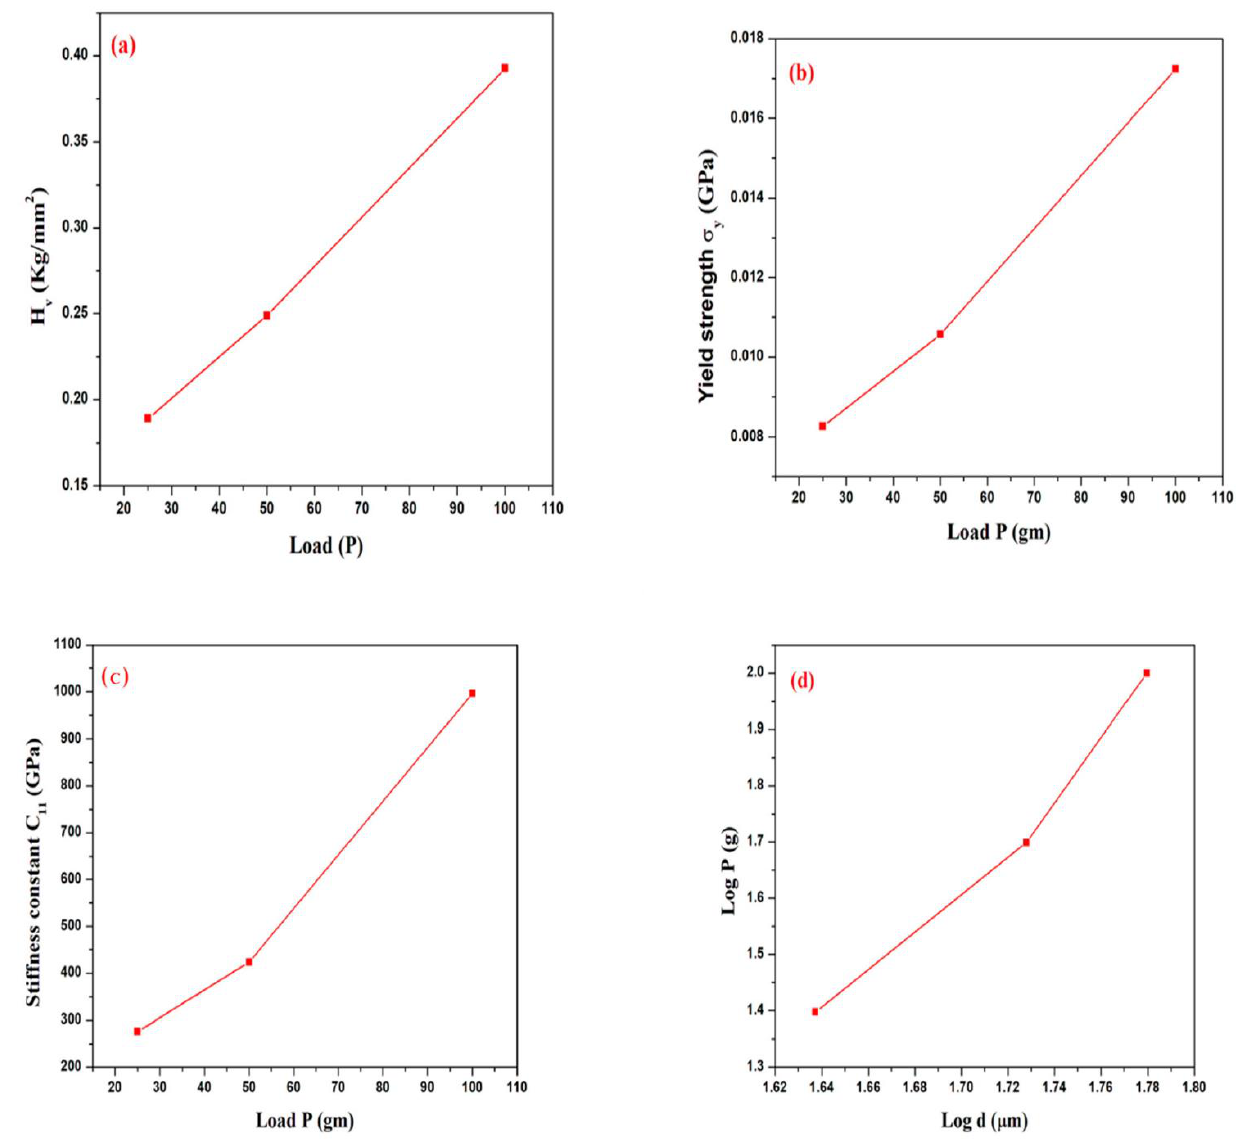
Figure 11. ( a ) Hardness number, ( b ) yield strength, ( c ) stiffness constant, and ( d ) log d versus log P.